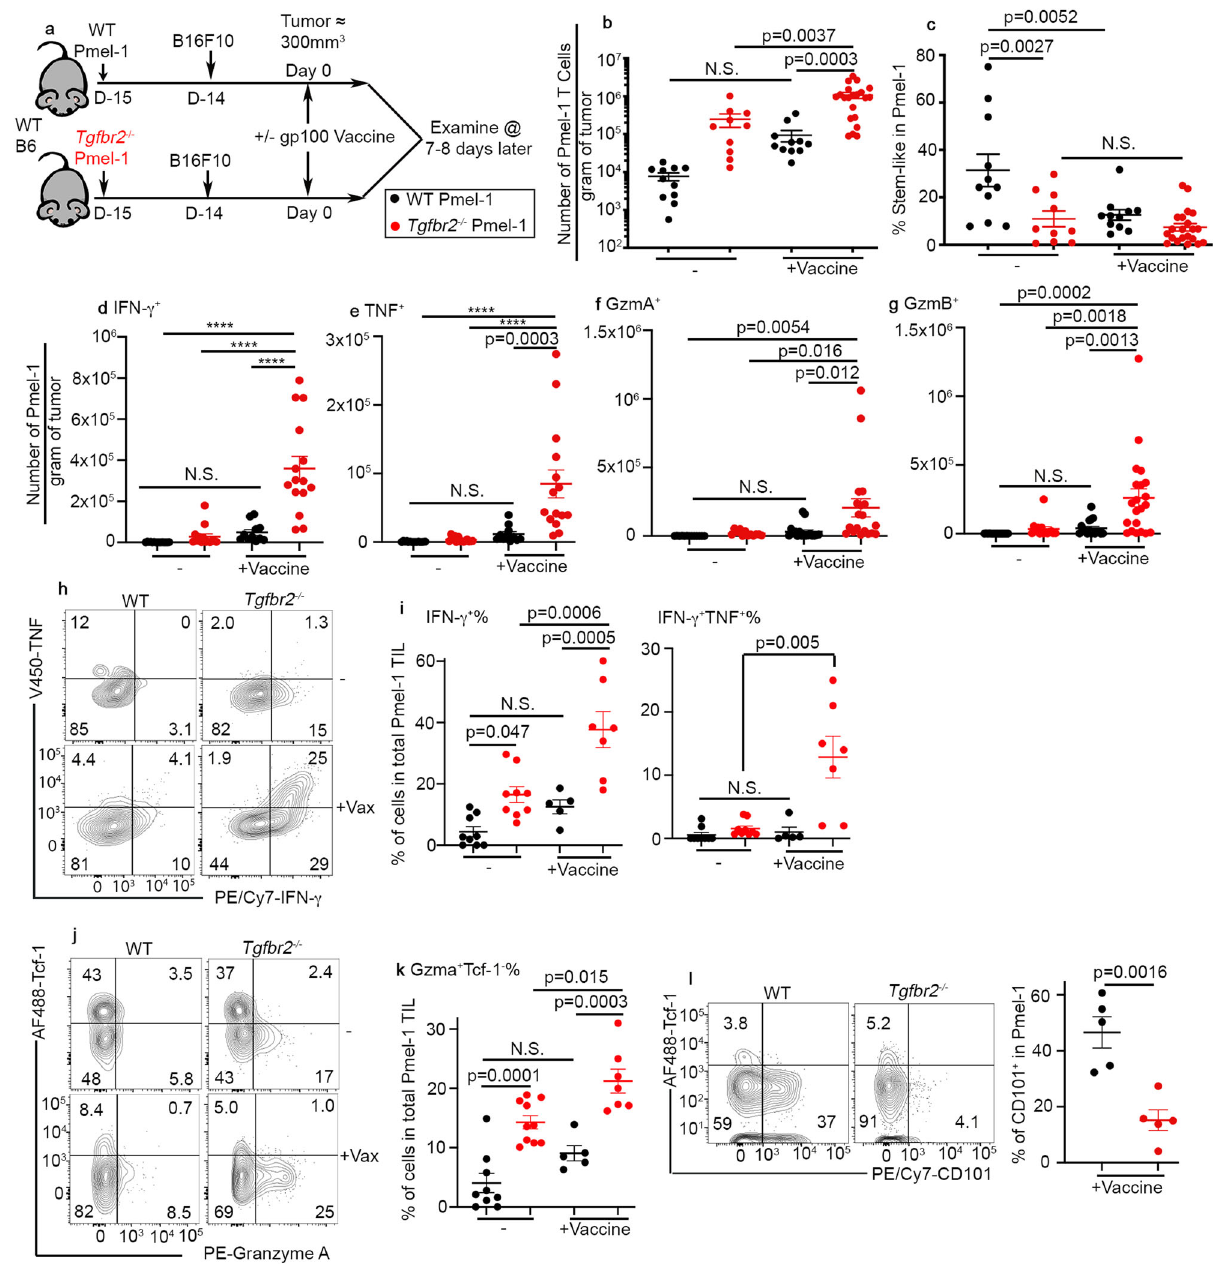
Fig. 2 | Increased accumulation of Tgfbr2 − / − effector CD8 + T cells inside tumor after vaccination. a Experimental design. Black symbols, WT and red symbols, Tgfbr2 − / − . b The number of Pmel-1 T cells per gram of tumor is shown. c The per- centageofstem-likesubsetinPmel-1Tcellsisolatedfromtumorisshown.For b and c , WT, n =11, Tgfbr2 − / − , n =10, WT+Vaccine, n =11 and Tgfbr2 − / − +Vaccine, n =21.Per gram of tumor, the numbers of Pmel-1 T cells producing IFN- γ ( d ), TNF ( e ), Gran- zyme A ( f ),and Granzyme B ( g ) are shown. For d and e , WT, n =15, Tgfbr2 − / − , n =14, WT+Vaccine, n =11 and Tgfbr2 − / − +Vaccine, n =15. For f , WT, n =13, Tgfbr2 − / − , n =12, WT+Vaccine, n =17and Tgfbr2 − / − +Vaccine, n =19.For g ,WT, n =15, Tgfbr2 − / − , n =14, WT+Vaccine, n =17and Tgfbr2 − / − +Vaccine, n =21. h RepresentativeFACSpro fi lesof TIL Pmel-1 T cells are shown. i The percentage of IFN- γ + (left) and IFN- γ + TNF + TIL